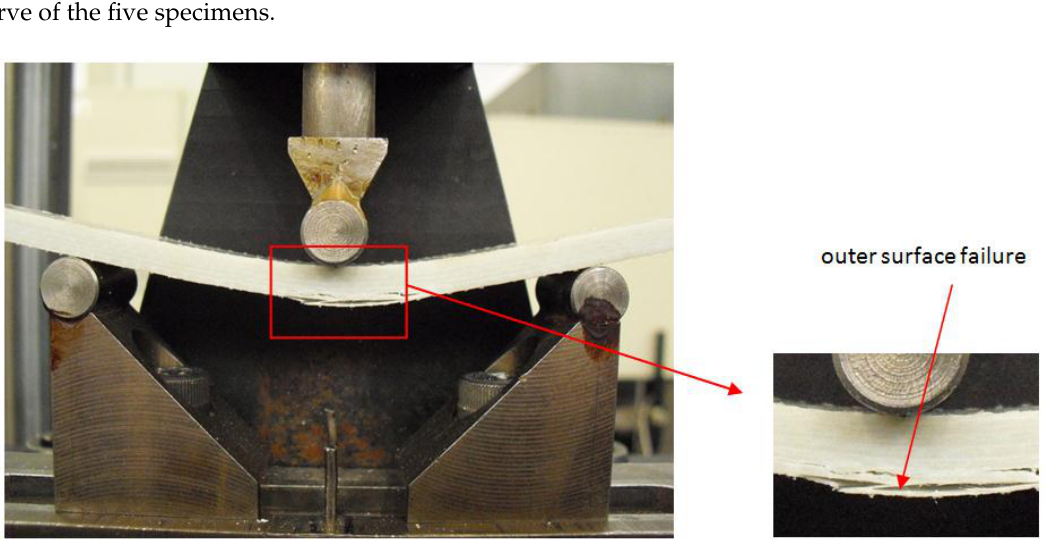
Figure 6. Failure mode of the flexural test specimen.